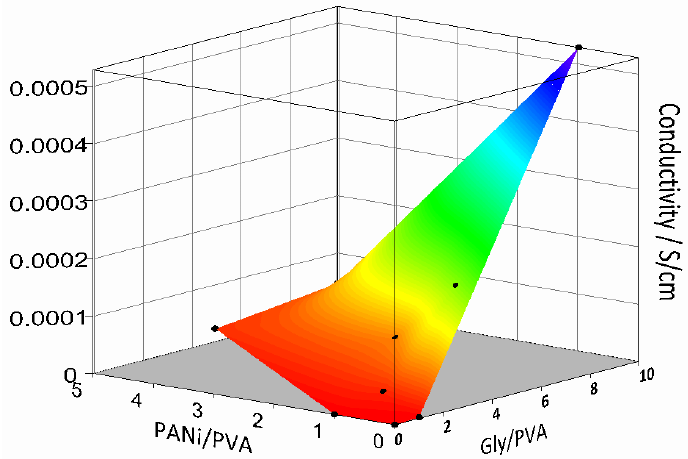
Figure 4. Surface plot showing the conductivity of the elastic PANi/PVA with composition, namely the ratio of the PANi/PVA and Gly/PVA after 60 days drying at room temperature and ambient conditions.